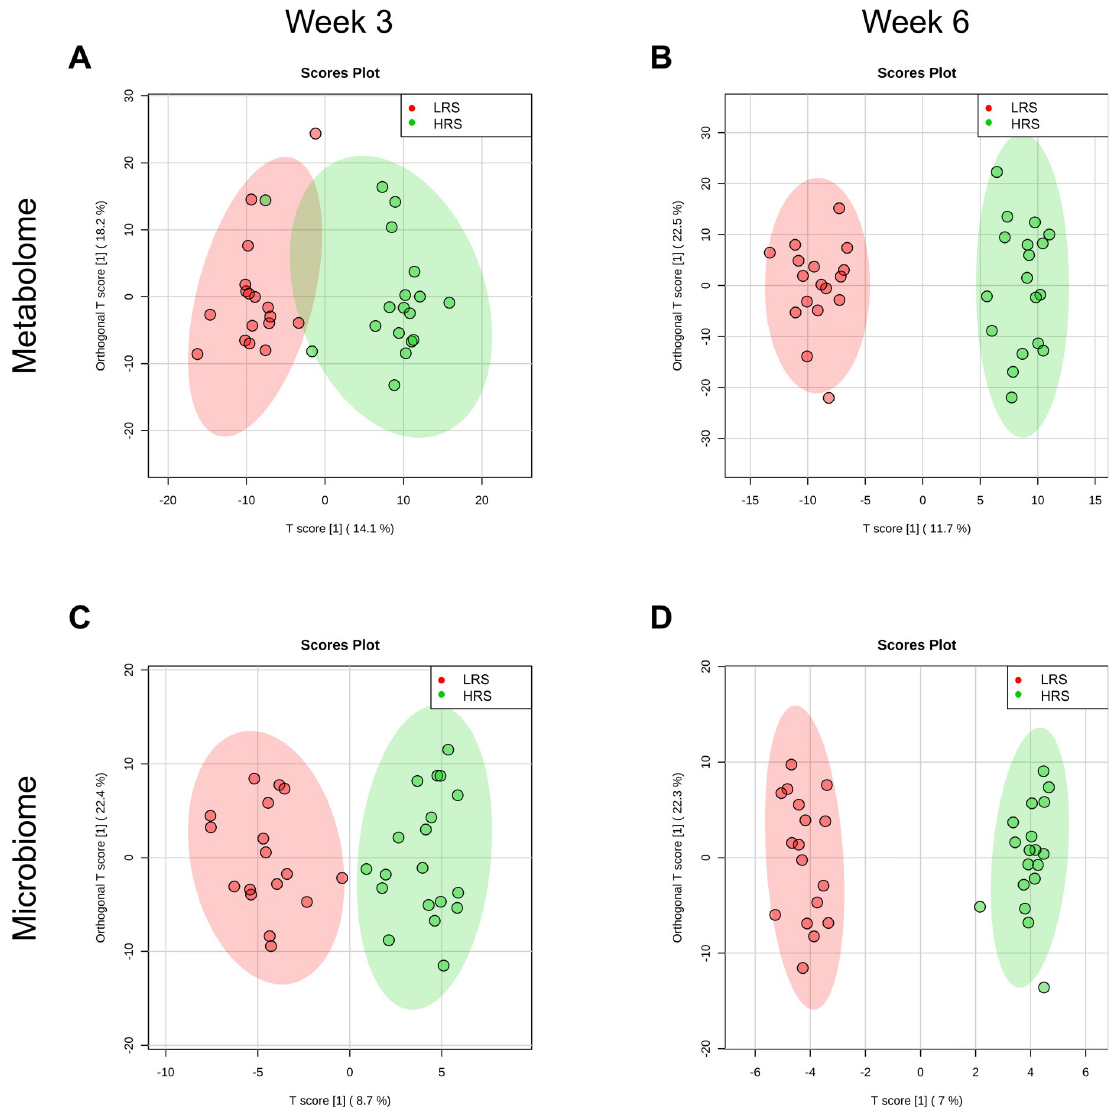
Fig 1. Orthogonal partial least squares analysis of whole fecal differences at weeks 3 and 6 between LRS and HRS food-fed cats for the metabolome (A,B) and microbiome (C,D). Shading indicates 95% confidence regions. Metabolome permutation statistics at week 3 were: Q2 = 0.38, P < 0.001; R 2 Y = 0.80, P = 0.014 and at week 6 were: Q2 = 0.86, P < 0.001; R 2 Y = 0.96, P < 0.001. Microbiome permutation statistics at week 3 were: Q2 P < 0.001; R2Y P = 0.059 and at week 6 were: Q2 P < 0.001; R2Y P = 0.056. HRS, high resistant starch; LRS, low resistant